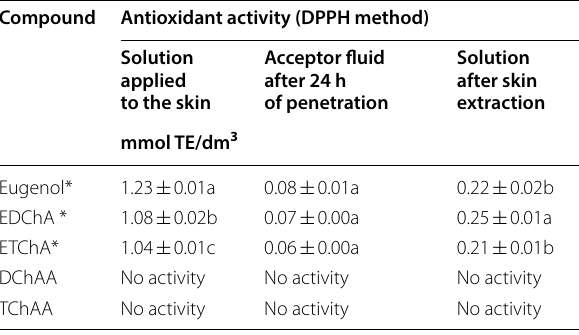
Table 2 Antioxidant activity of 1% solutions of the test compounds applied to the skin, acceptor fluid obtained after 24 h of collection, and solutions obtained after skin